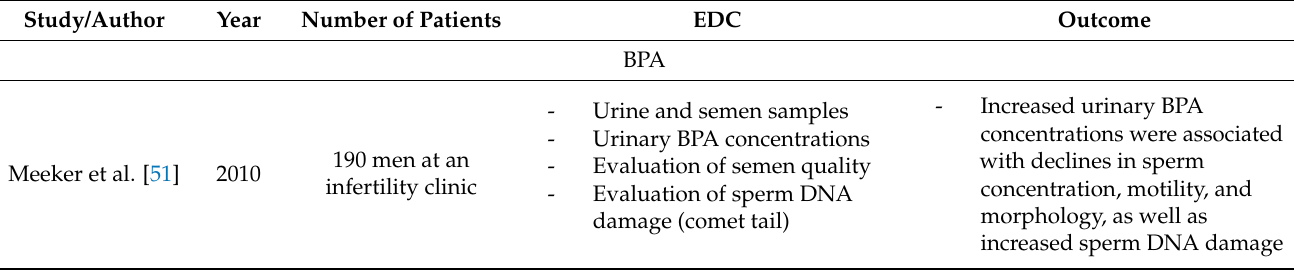
Table 1. Association of endocrine-disrupting chemicals—bisphenols, phthalates, and parabens—with human semen quality and oxidative stress: review of the studies.